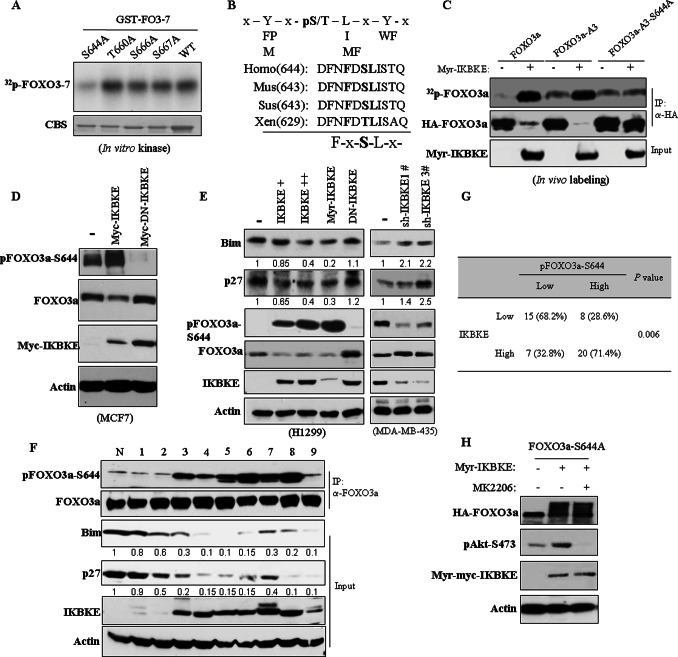
Direct phosphorylation of FOXO3a-S644 by IKBKE in vitro and in vivo.(A) Mutation of Ser644 into alanine reduced IKBKE phosphorylation of C-terminal region of FOXO3a. In vitro IKBKE kinase assay was carried out using C-terminal region of FOXO3a (e.g. GST-FO3-7) containing indicated Ser/Thr-Ala mutation as substrates. (B) Sequence alignment of FOXO3a-S644 with putative IKBKE phosphorylation consensus motif (25). (C) IKBKE phosphorylates FOXO3a-S644 in vivo. H1299 cells were transfected with indicated plasmids and labeled with [32P]-orthophosphate. Following immunoprecipitation with anti-HA antibody, the immunoprecipitates were separated by SDS-PAGE, transferred and then exposed (top). Expression of transfected plasmids is shown in panels 2 and 3. (D and E) IKBKE induces endogenous FOXO3a-S644 phosphorylation and reduces p27 and Bim expression Indicated cells were transfected with different forms of IKBKE and shRNA-IKBKE, and then immunoblotted with indicated antibodies. (F and G) Expression of IKBKE positively correlates with pFOXO3a-S644 level in NSCLC specimens. Representative tumors were lysed, immunoprecipitated and probed with indicated antibodies (F). Chi-square test analysis of IKBKE and pFOXO3a-S644 in 50 NSCLC specimens examined. The correlation is significant (p = 0.006; G). (H) MCF7 cells were transfected with indicated plasmids. Following incubation for 48 h, cells were treated with and without Akt inhibitor MK2206 for 2 h and then immunoblotted with indicated antibodies.